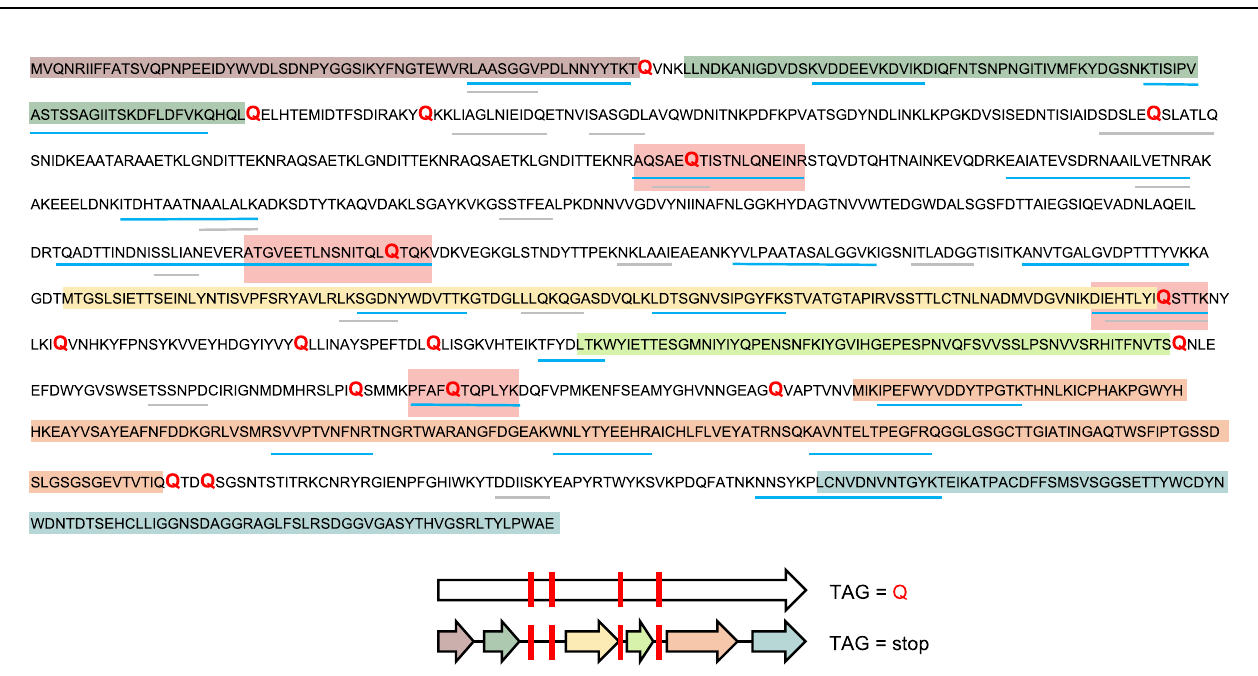
Fig. 1 | Proteomic detection of alternatively coded proteins from two phage genomes. L2_026_000M1_scaffold_35 ( A ) and L3_063_250G2_scaffold_974_curated ( B )arealternativelycodedcrAss-likephages.Predictionofgenesincode11(middle gray ring) leads to gene fragmentation and low coding density, while gene pre- diction in code 15 (outer yellow ring) restores open reading frames. Genes with detected peptide evidence are colored purple. Some detected peptides contain